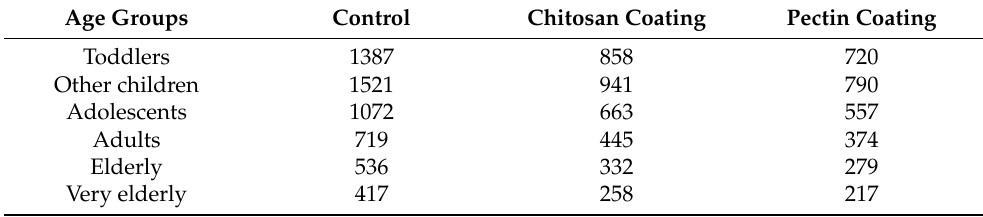
Table 5. Dietary intake of acrylamide consumption [ng · (kg · body · weight) − 1 · day − 1 ] based on the median of the estimated consumption of fried potatoes treated with the coating solutions. (Adapted with permission from Al-Asmar [199]; published by MDPI,